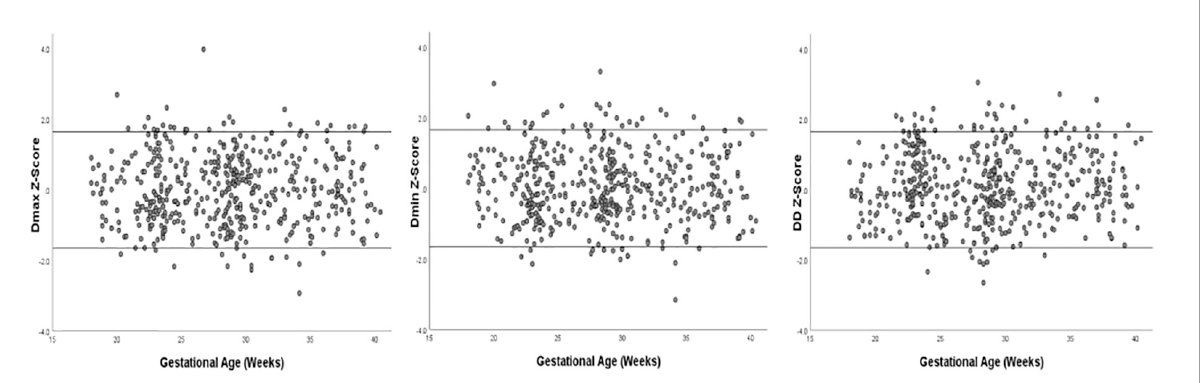
FIGURE5 Scatter plot of Z-score distribution of Dmax, Dmin, and DD (Diameter Distensibility) based on gestational age ( n = 490), with tram lines at 1.96 and −